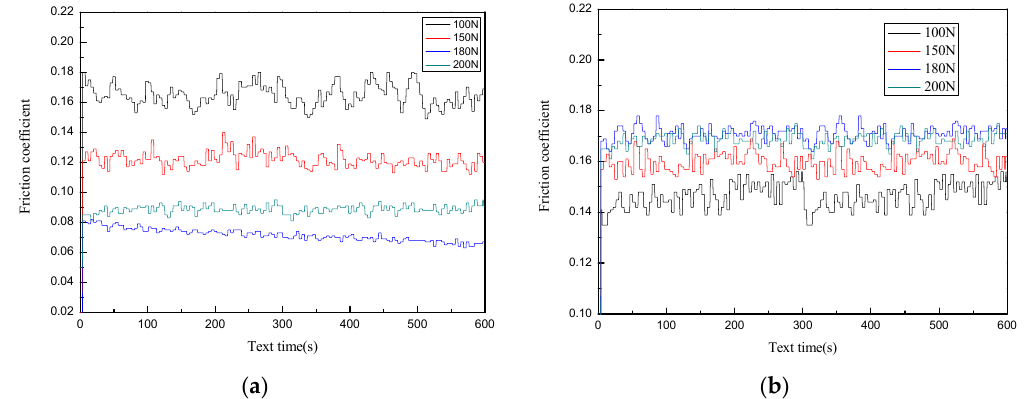
Figure 8. Friction coe ffi cients of the unpolished sample and polished sample: ( a ) friction coe ffi cient